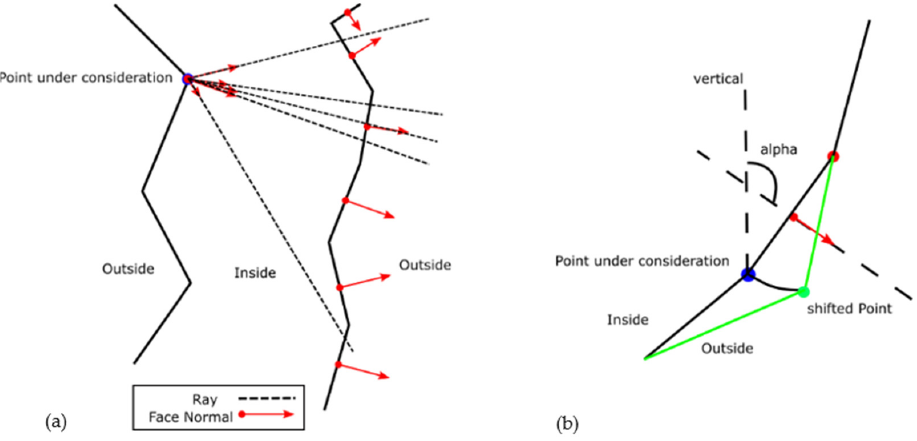
Figure 14. ( a ) graphical representation of the minimum thickness rule and ( b ) graphical representation of a rule to limit the overhang. Table 3. Parameter of the geometry finding process with thickness